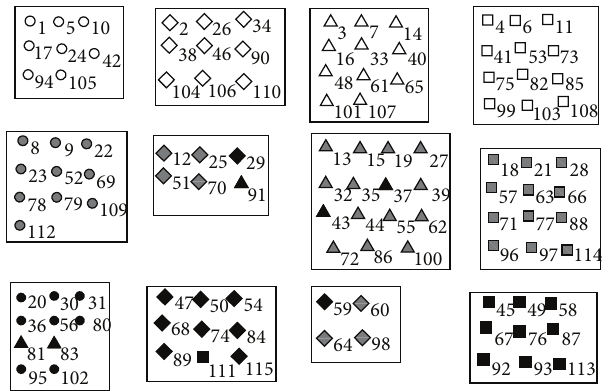
Figure 12: Communities obtained by LPAp on unweighted football